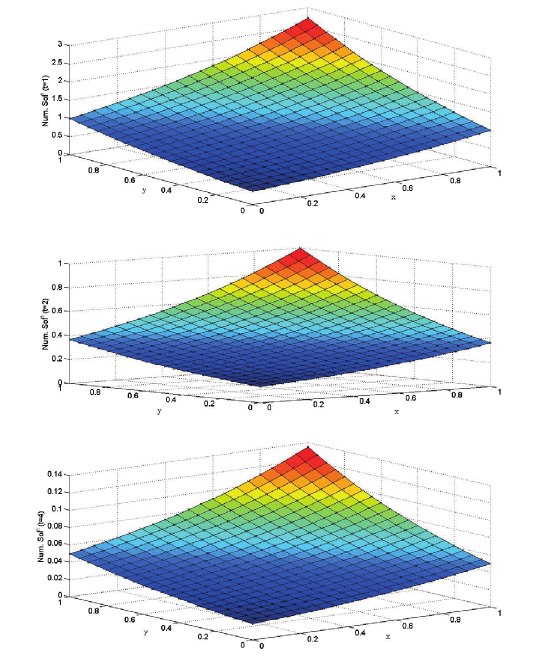
Fig. 3: Plots of mExp-DQM solutions solutions at different time lev- els for Example 5.2